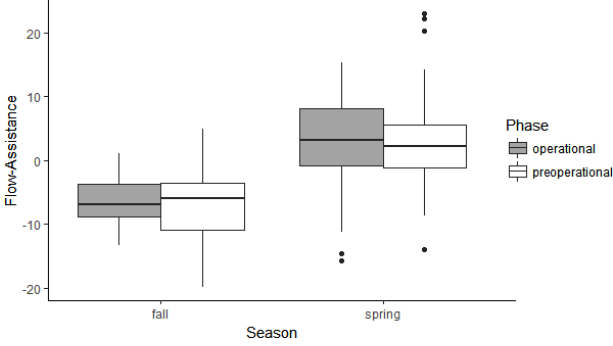
Fig. 3 . Flow-assistance, a vector measure of the effect of wind direction and speed on the ability of birds to maintain their intended migratory direction and speed, was compared between the preoperational phases (2008–2010) and operational phases (2011–2012) at the Dokie I Wind Energy Project in northeast British Columbia. Data is partitioned into spring and fall migration. Positive values of flow assistance indicate wind direction and strength that would assist migrants in maintaining direction and airspeed, with values ~ +20 representing full and strong tail winds. Stronger negative values represent increasing impediments to maintain migratory direction and airspeed, with values of ~ -20 representing strong headwinds. Migrants in the spring gain positive flow-assistance, but this did not differ between preoperational and operational phases of the wind facility. Fall migrants had significantly lower flow-assistance than fall migrants, but this did not differ between preoperational vs operational